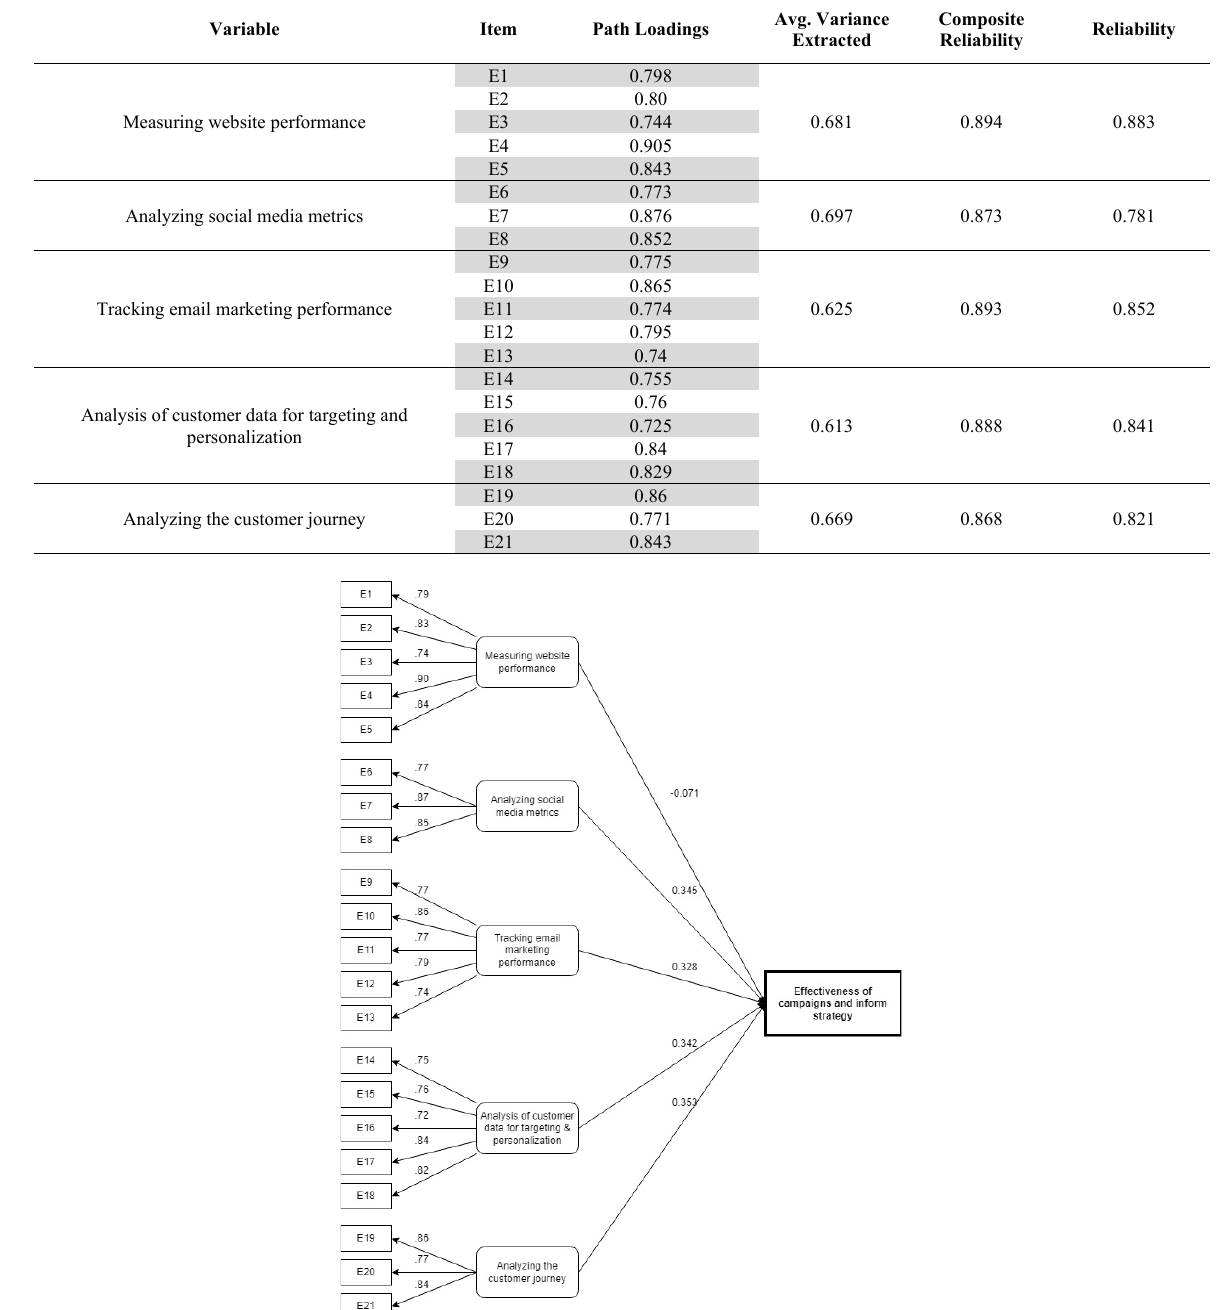
Fig. 2. SEM Variables and Data